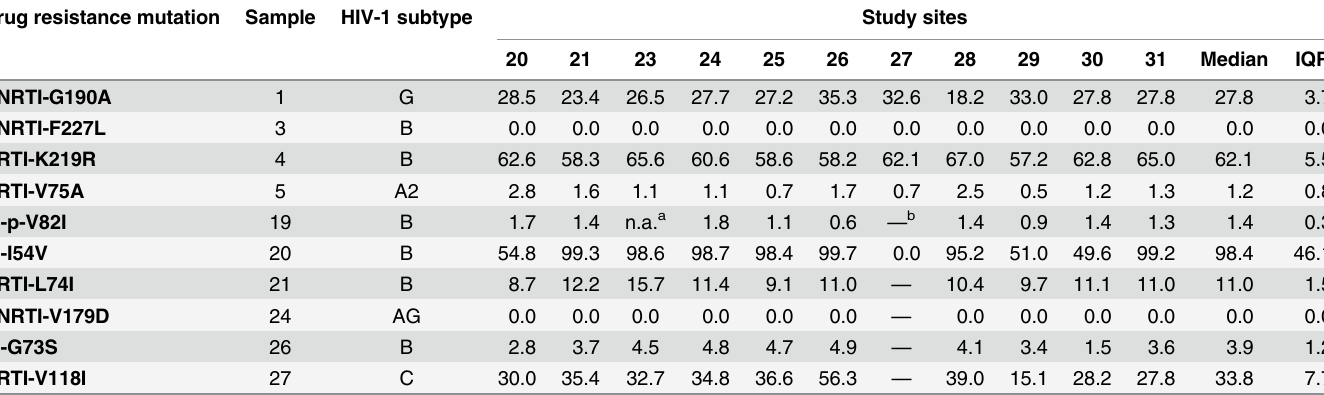
Table 1. Detection across sites of 10 preselected variants. The table lists the percentage of reads carrying the codon variant. Drug resistance mutation Sample HIV-1